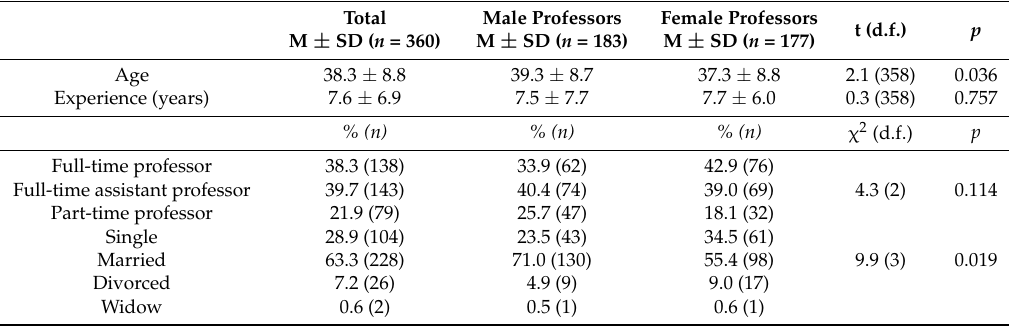
Table 1. Sociodemographic characteristics of the